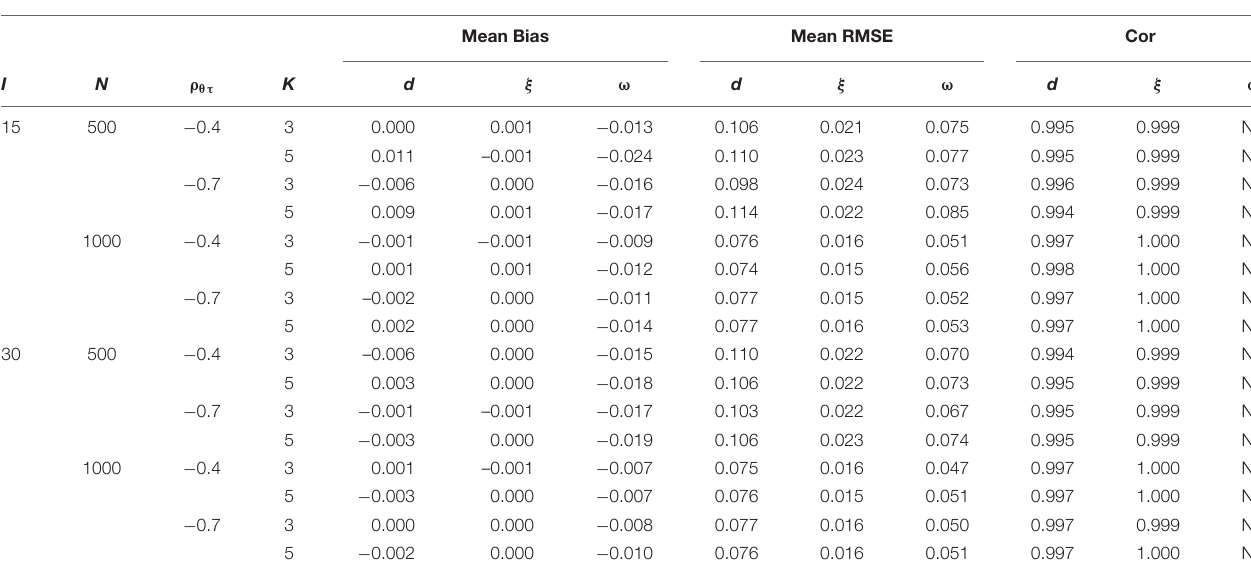
FIGURE 1 | K-by-I Q’ matrix in the simulation study 1. D = dimension of latent ability; items with * are used for I = 15 conditions. TABLE 4 | Recovery of item parameters in simulation study